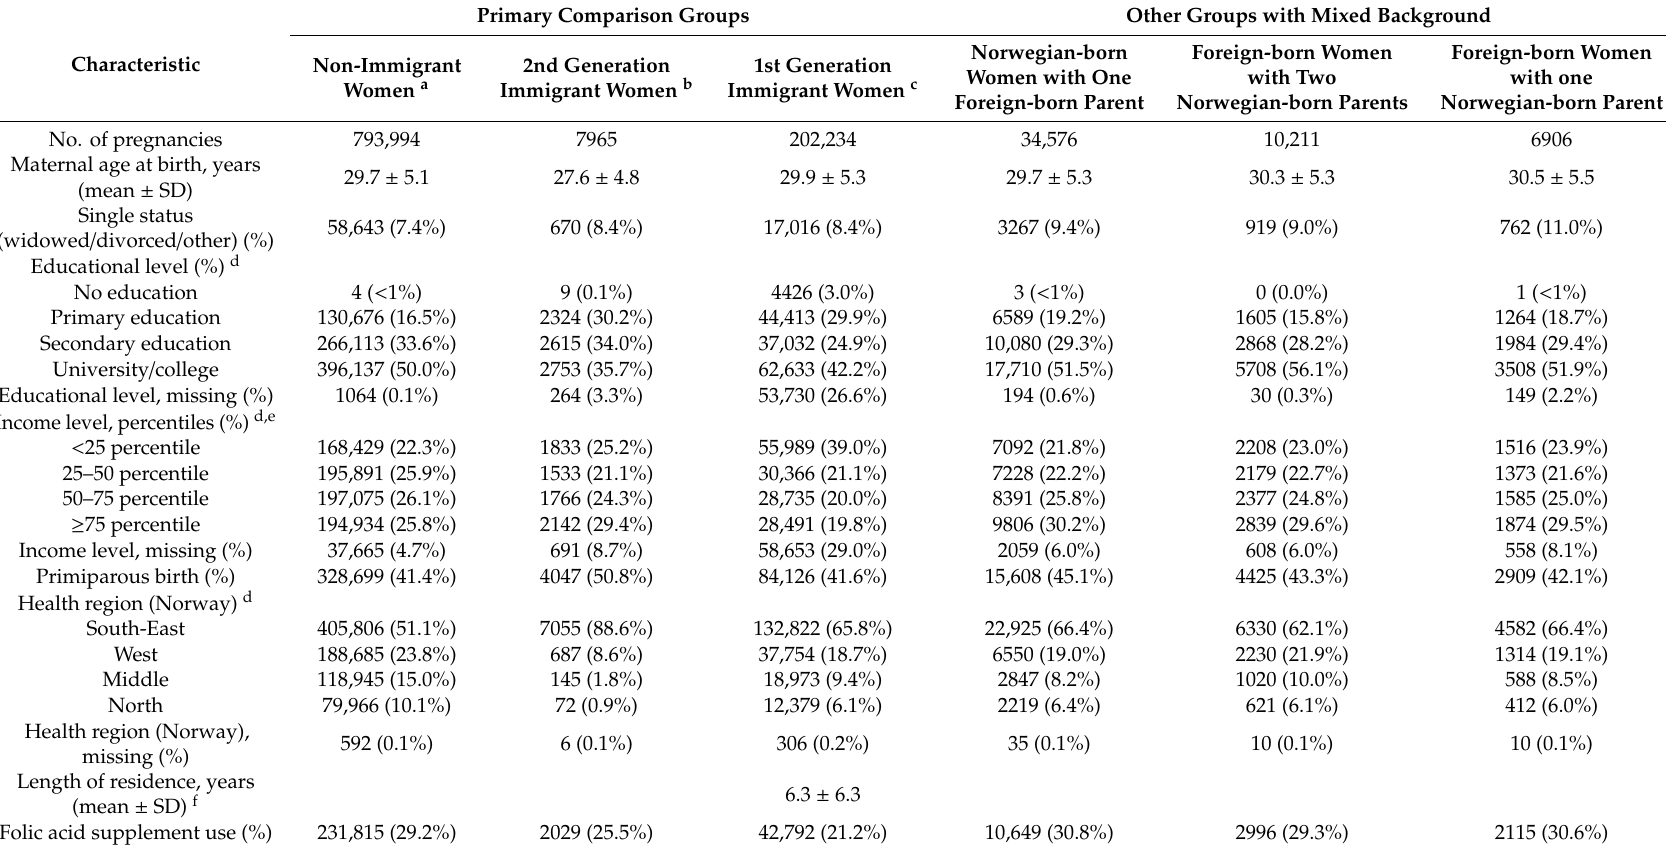
Table 1. Sample characteristics by maternal immigrant category